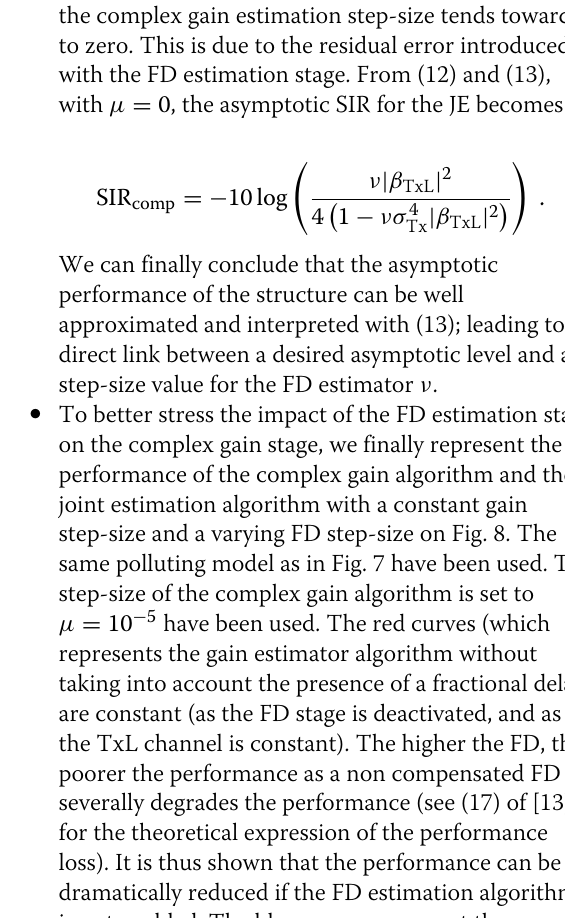
becomes linear w.r.t the complex gain step-size μ (for small μ ) as, in this case, (13) becomes (cid:23) (cid:22) /( 2 − μσ 2 ) − 10 log μσ 2 u u . xb